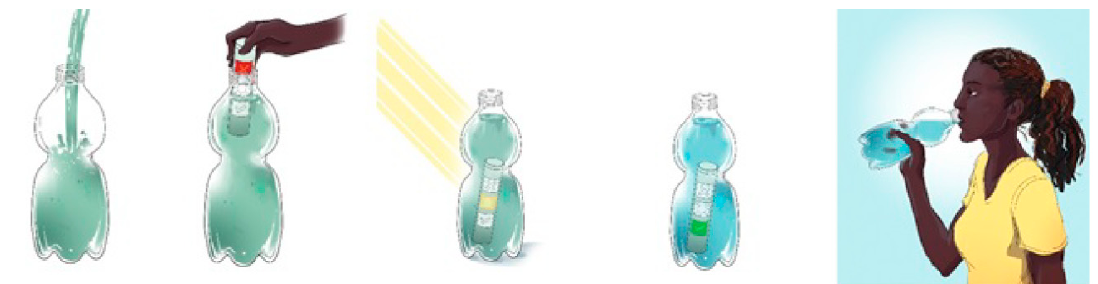
Figure 2. Scipio enhanced application of the SODIS